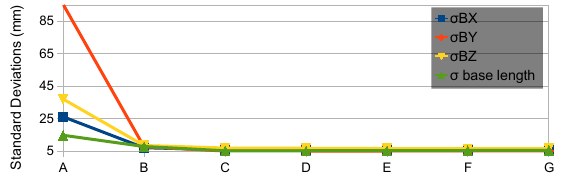
Figure 9. Average values for the standard deviations of discrepancies in tie points coordinates of 5 rectified image pairs with different sets of IOP and ROP, after scale change in the right